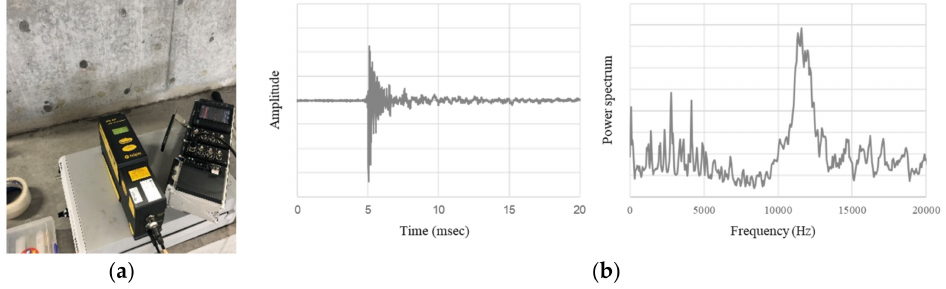
Figure 4. ( a ) Laser doppler vibrometer; ( b ) Detected waveform with application of laser